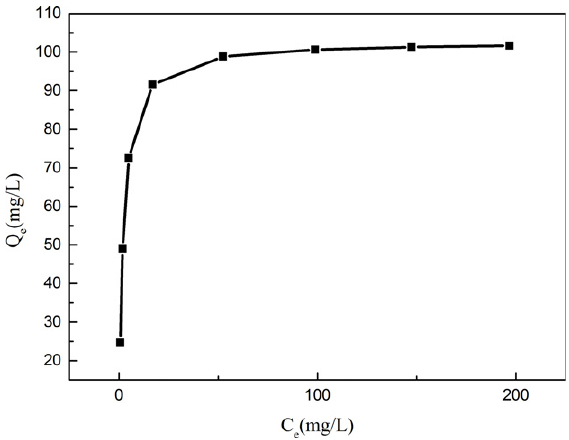
Figure 14: Adsorption isotherms of lead ions on the amino- functionalized MCM-41 adsorbent